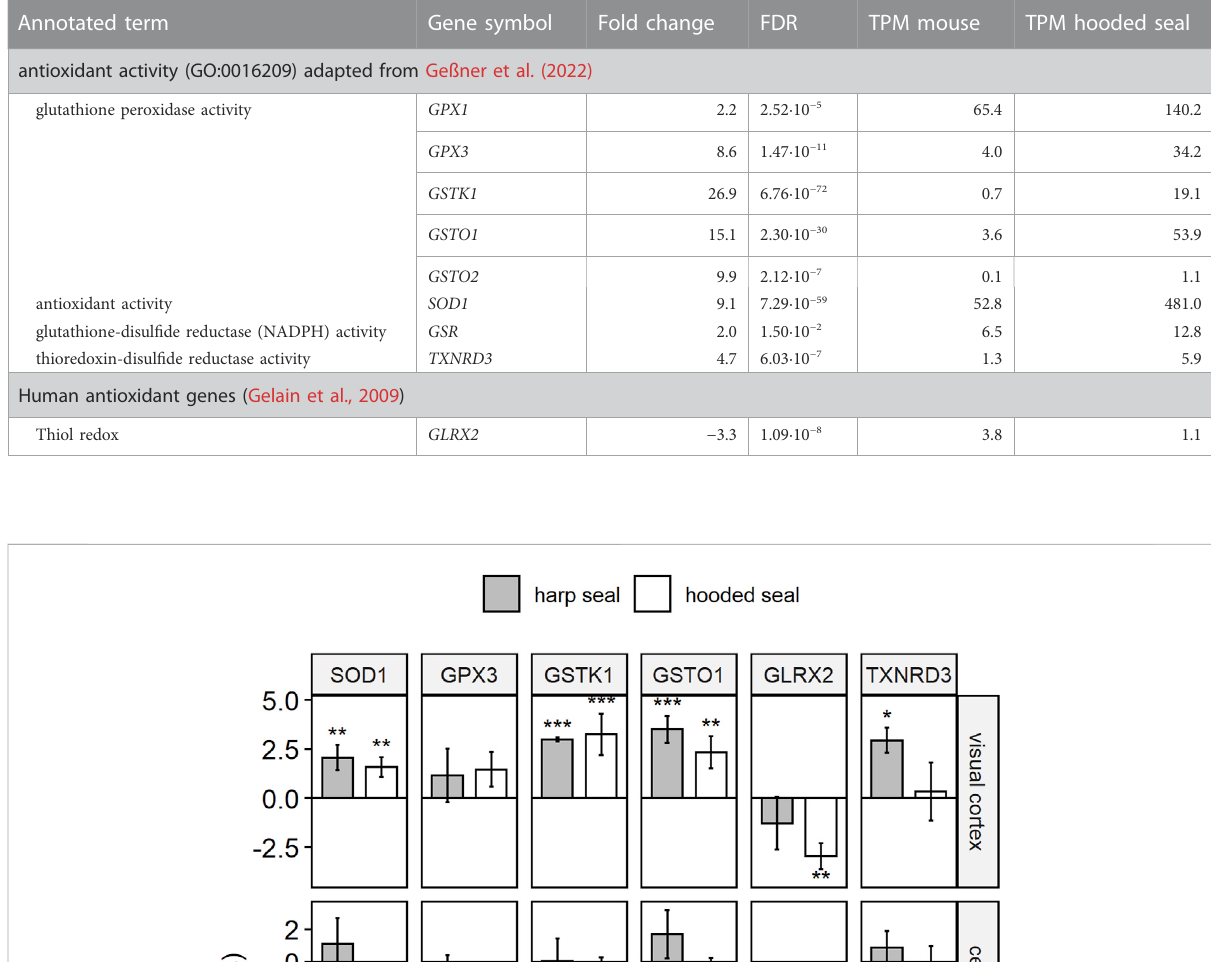
TABLE 1 Antioxidant gene expression in visual cortex neurons of hooded seals ( Cystophora cristata ), expressed in relation to gene expression in mice ( Mus ≤ 0.05, TPM-value ≥ 1 and a fold change ≥ 2 or ≤ -2. p p -value corrected for multiple testing using the False Discovery musculus ), with a p FDR FDR represents the Rate (FDR), while Transcripts Per Kilobase Million mapped reads (TPM) represent normalized expression values. Only genes analysed in qPCR, and/or for which enzyme activity assays were available, are presented. For a complete list, please see Supplementary Table S2.